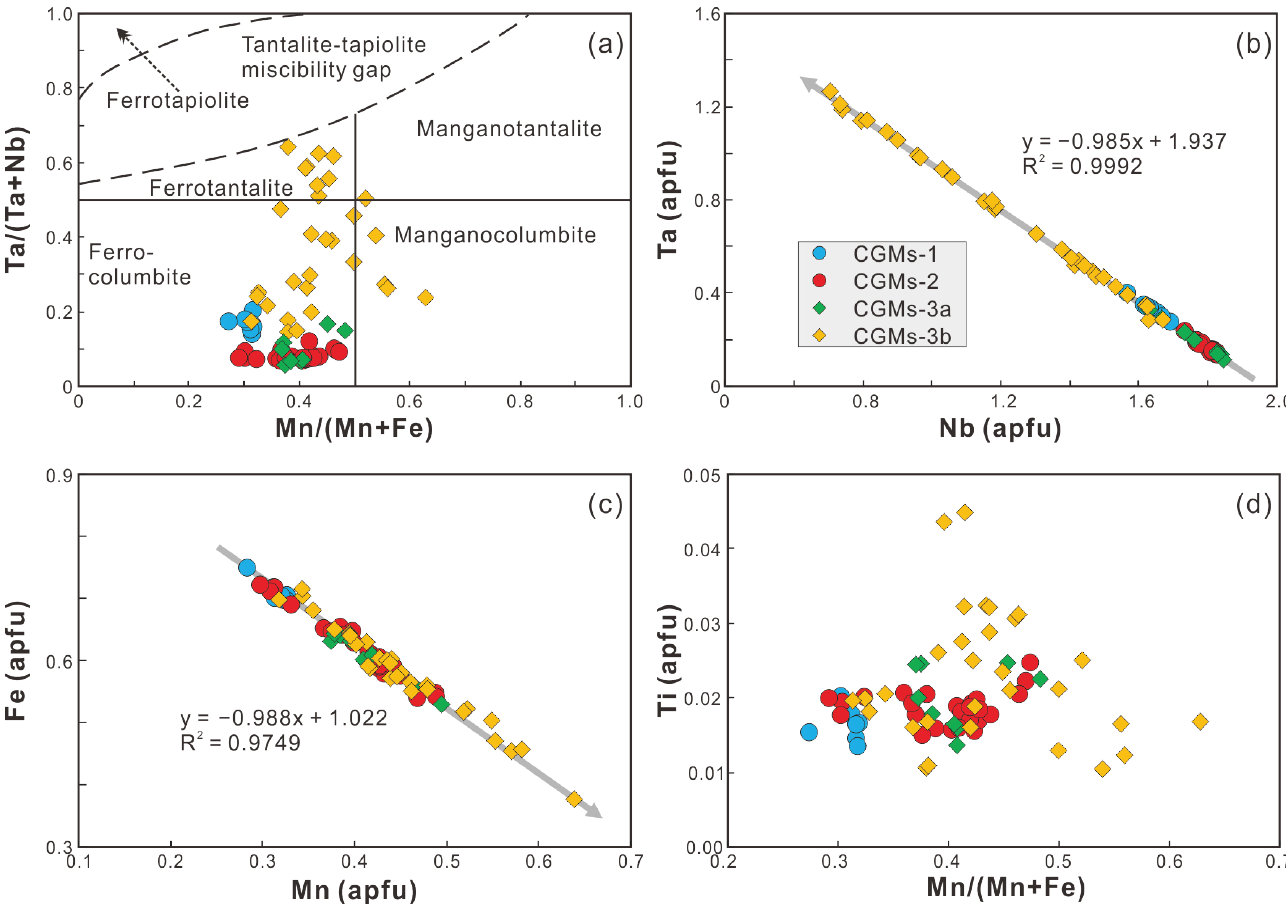
Figure 7. Major-element compositions in CGMs from the CKBS deposit expressed in terms of ( a ) Mn/(Mn + Fe) vs. Ta/(Ta + Nb) (after ˇCerny and Ercit [17]), ( b ) Nb (apfu) vs. Ta (apfu), ( c ) Mn (apfu) vs. Fe (apfu) and ( d ) Mn/(Mn + Fe) vs. Ti (apfu). Table 2. Analytical results of U-Pb isotopes and calculated ages for CGMs grains in the spodumene pegmatite from the CKBS